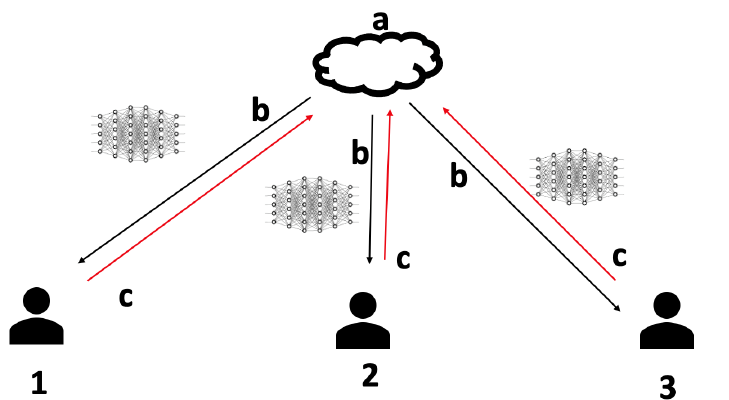
Figure 1. Federated learning